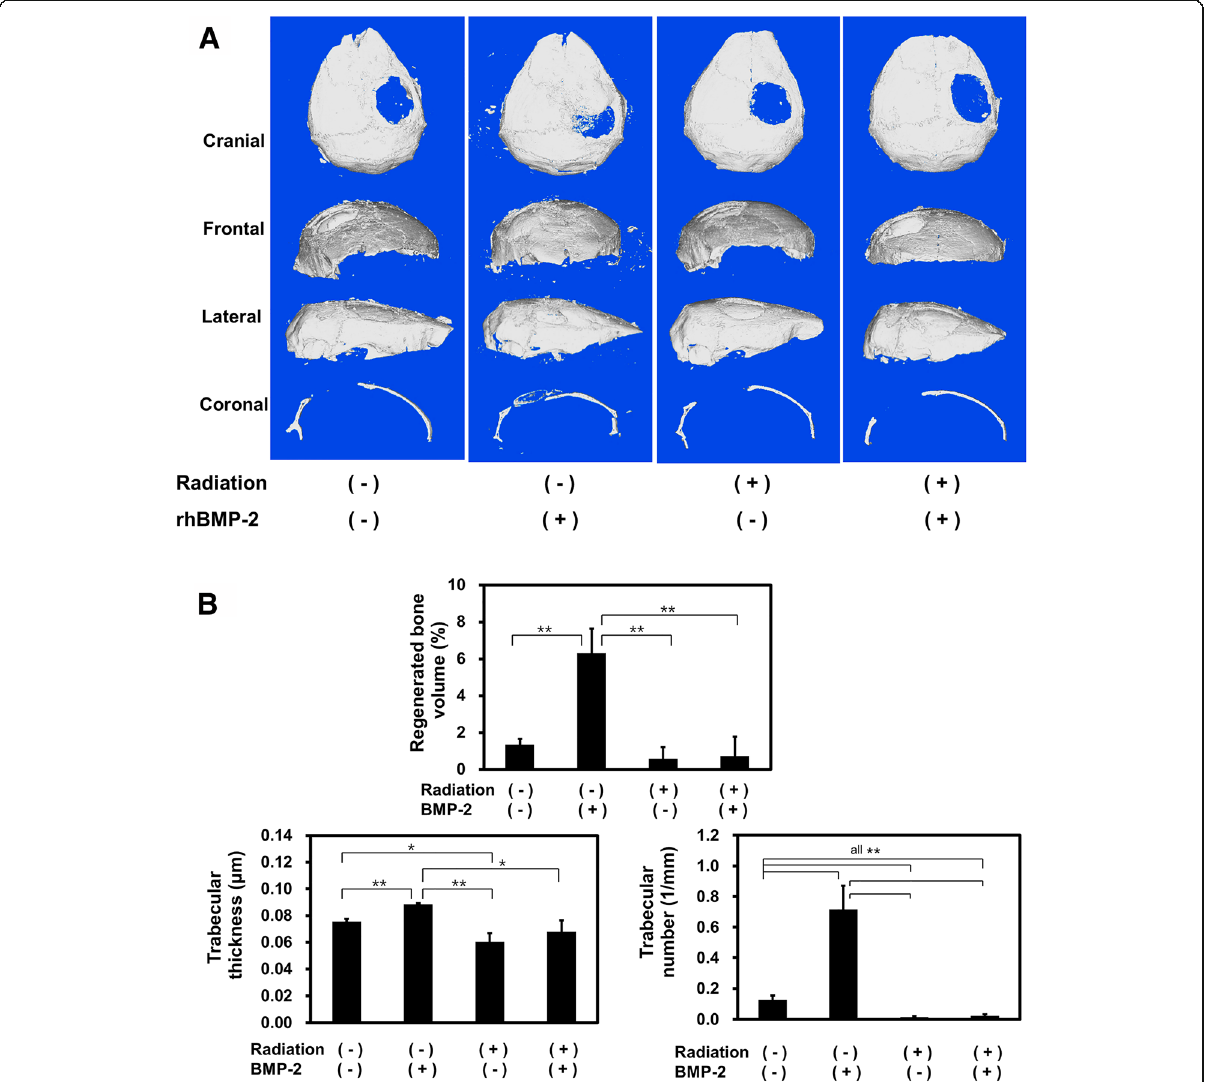
Fig. 4 μ CT evaluation of bone regeneration in the mouse calvarial defect regeneration model. a Each μ CT image of the experimental groups. b Bone density analysis of the mouse calvarial defect regions for percent bone volume and trabecular thickness and trabecular number, in bone volume (%) and trabecular number. Significant inter-group differences to the other group were represented as * p < 0.05 or ** p < 0.01